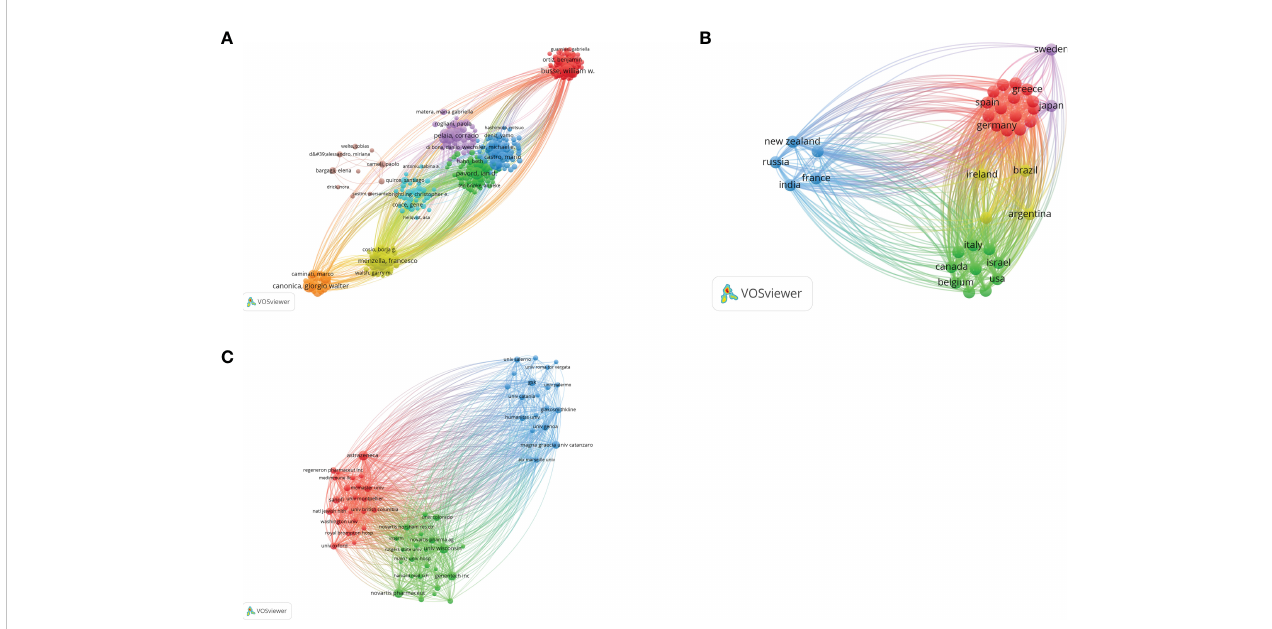
FIGURE 2 (A) The visualization map of collaborations between core authors. The lines between nodes represent cooperation between different authors. Each node represents one author. The size of the node is proportional to the number of documents published. (B) The cross-country collaboration visualization map. The lines between nodes represent cooperation between countries. Each node represents a country or region. The size of the node is proportional to the number of documents published; (C) The visualization map of collaborations between institutions. The lines between nodes represent cooperation between institutions. Each node represents one institution. The size of the node is proportional to the number of documents